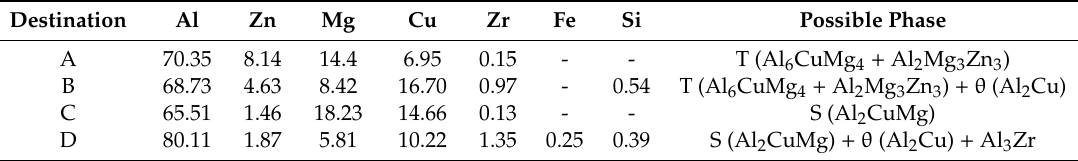
Table 4. EDS analysis of each phase indicated by the arrow in Figure 7. (at.%).